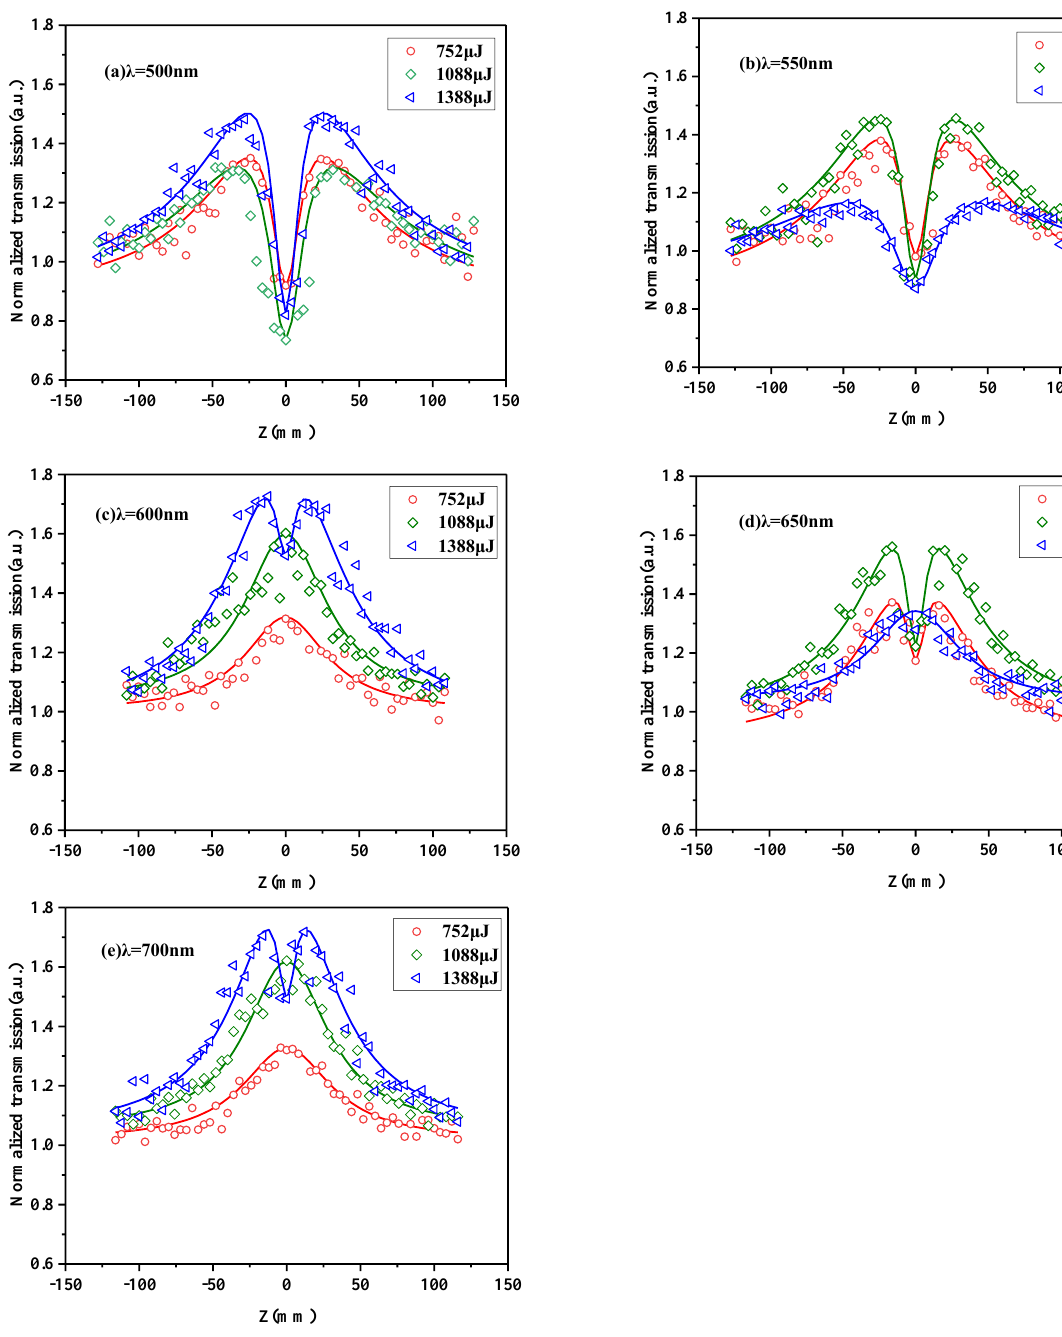
Figure 3. Normalized transmission of PtNPs for open aperture Z-scan measurements under different wavelengths of ( a ) 500 nm, ( b ) 550 nm, ( c ) 600 nm, ( d ) 650 nm, and ( e ) 700 nm. The dotted lines were experimental data, and the solid lines were theoretical fitting data. In order to better understand the above results, corresponding to Figures 3a–e and 4a–e show the relationship between the normalized transmission of PtNPs and the energy den- sity of the incident laser pulse. The dotted lines were experimental